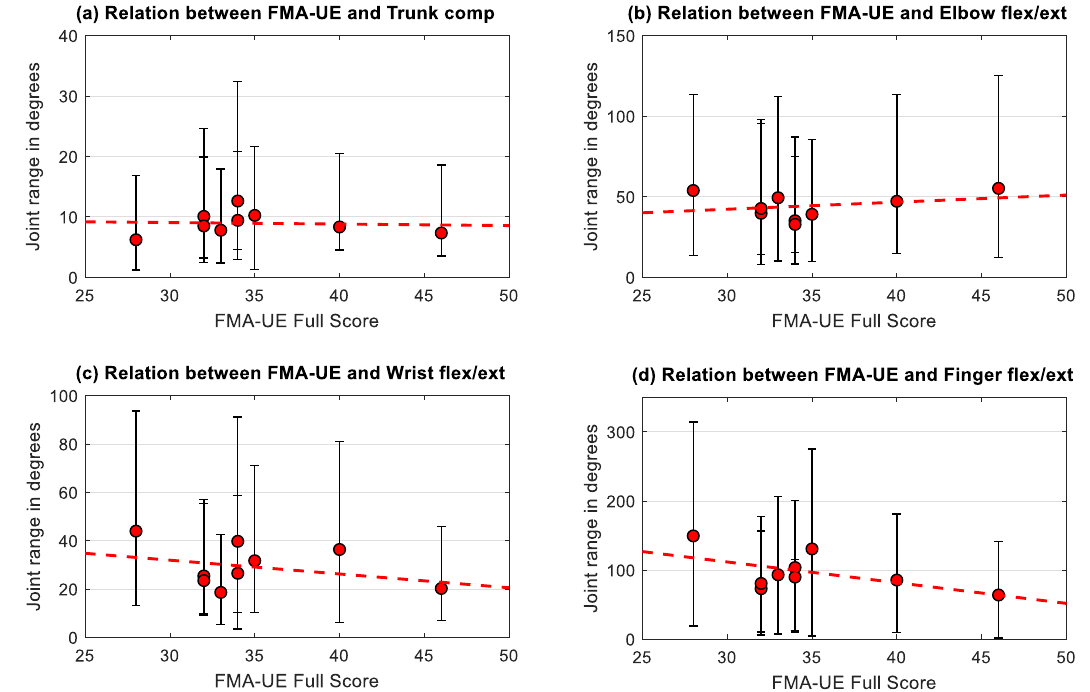
Figure 4. Subjects median joint range of ( a ) trunk compensation, ( b ) elbow, ( c ) wrist, and ( d ) finger flexion/extension of the affected side in relation to impairment level (FMA-UE score ranging from 0–66 points). Error bars represent the interquartile range over all trials performed by each of the nine subjects and the regression lines over the subjects are included for each